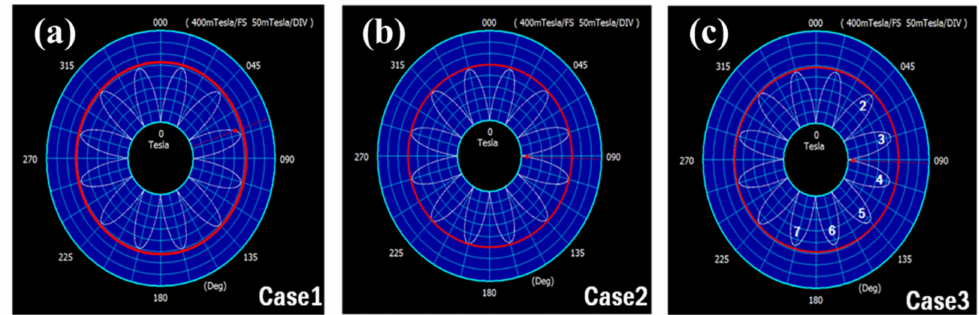
Figure 7. Surface flux analysis results of magnetized bonded permanent Nd 2 Fe 14 B magnet in ( a ) case 1; ( b ) case 2; and ( c ) case